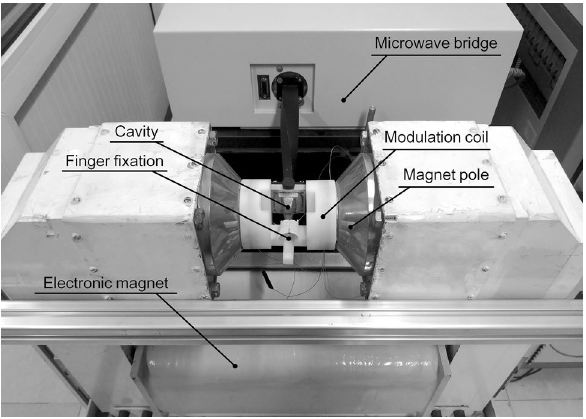
Figure 3. The X-band in vivo EPR spectrometer of fingernail dosimetry.